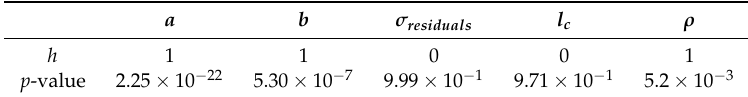
Table 9. Student’s t -test: the alternative hypothesis ( h = 1) is that the mean of the metric is greater than